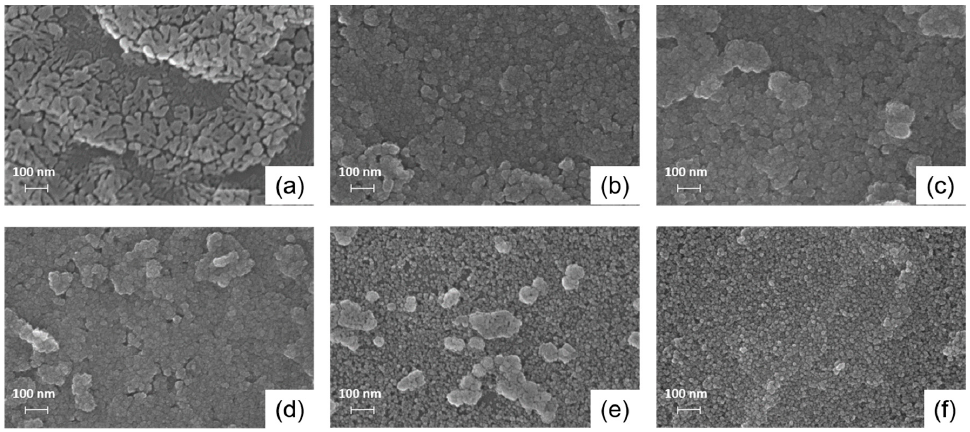
Figure 5. FESEM images of the ( a ) undoped; ( b ) 1%; ( c ) 3%; ( d ) 5%; ( e ) 7% and ( f ) 9% In-doped ZnO films.